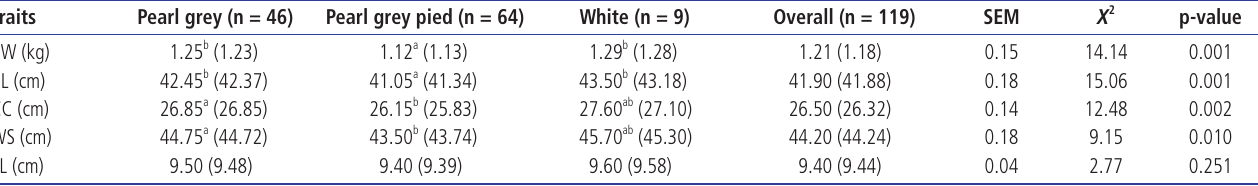
Table 7. Medians (means in parentheses) of morphometric traits measured in main male guinea fowl phenotypes 1)